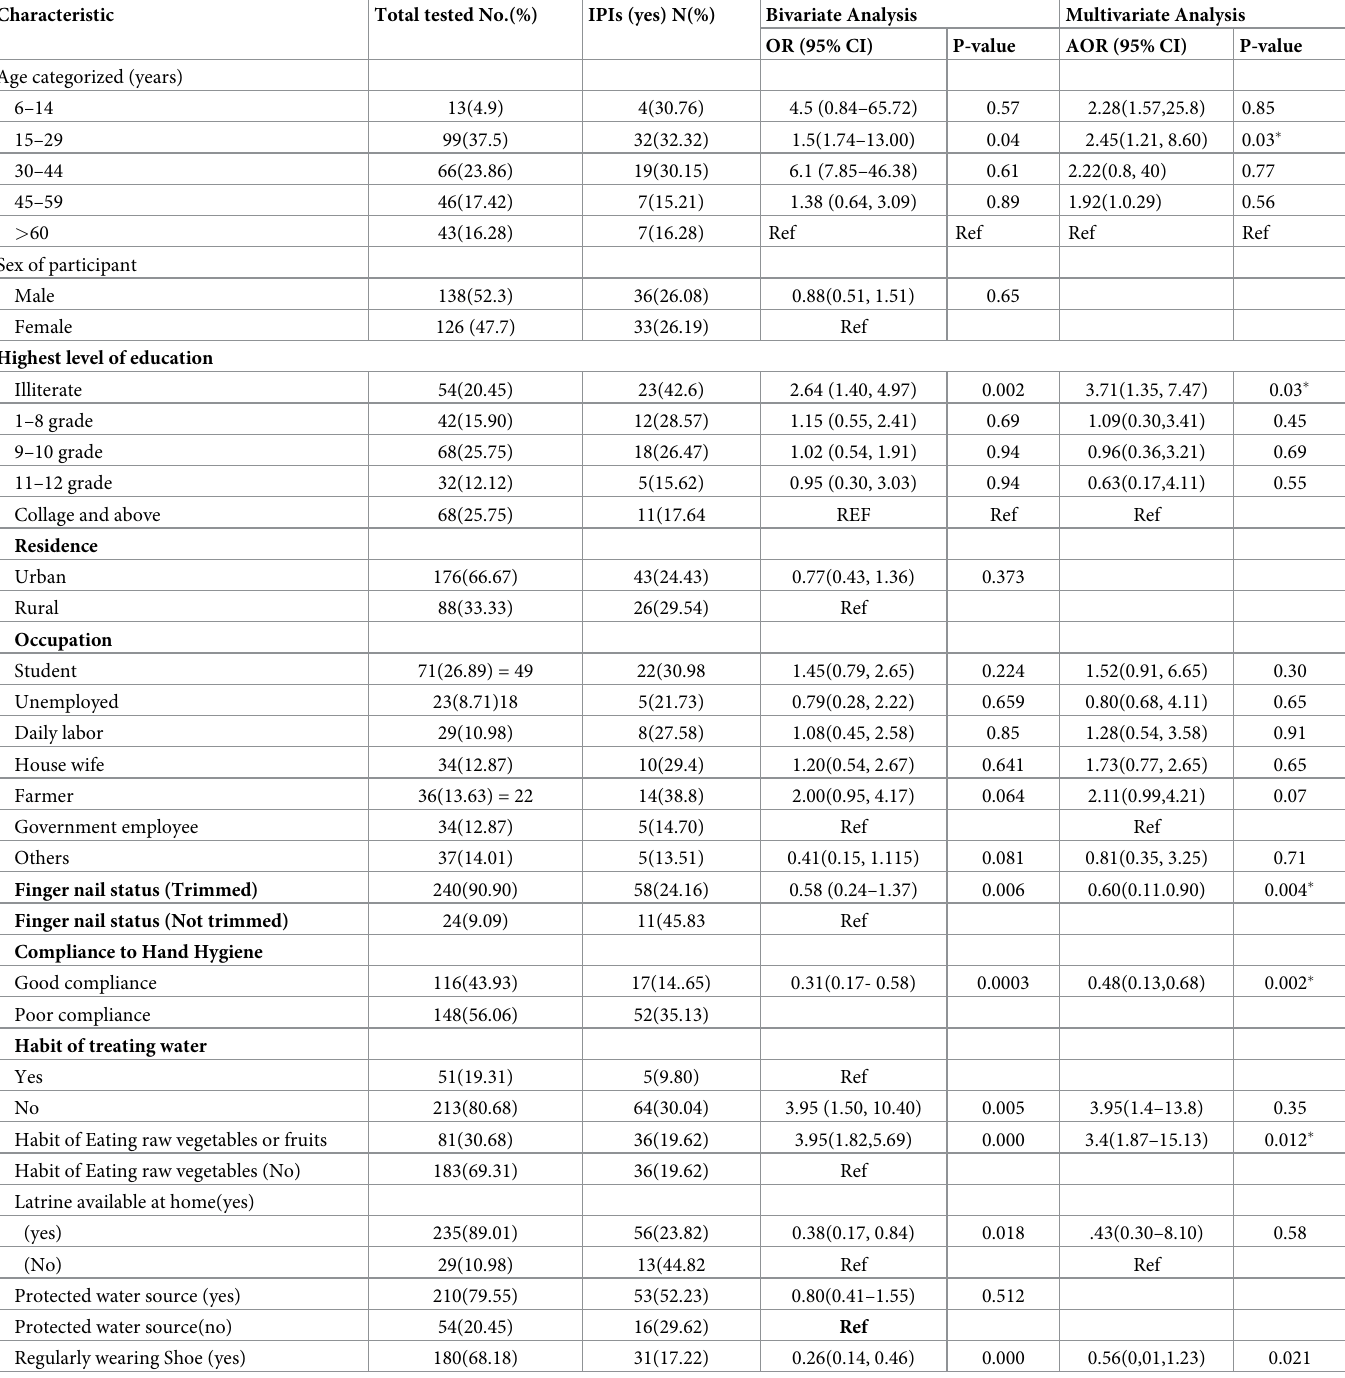
Table 4. Bivariate and multivariate analysis of factors associated with risk of intestinal parasite among patients attending Arba Minch general hospital outpatient department during COVID 19 pandemic, southern Ethiopia (from June to September 2021)(n = 264).